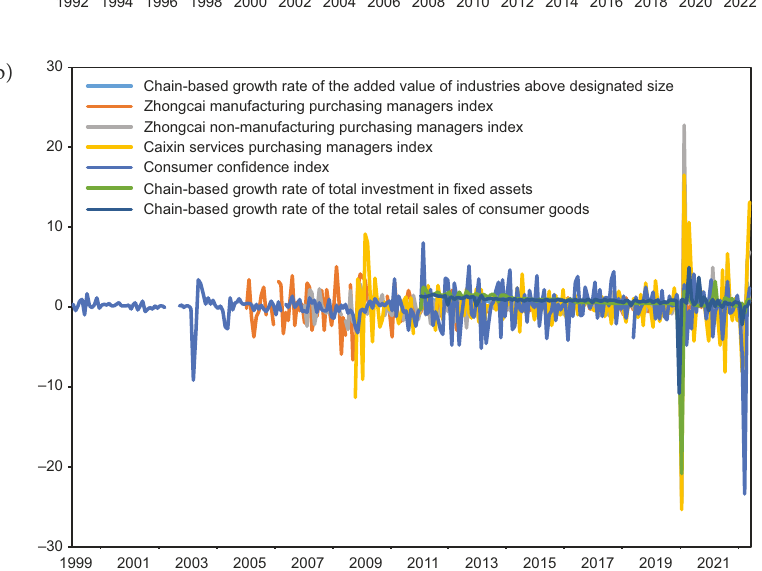
Figure D1. Trend graphs of fundamental factors on a monthly